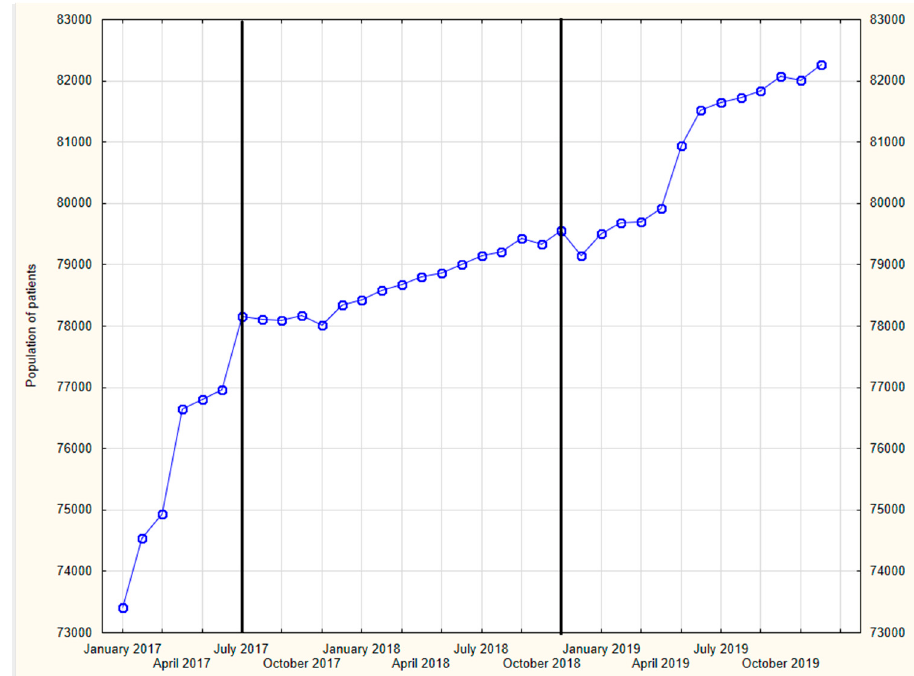
Figure 2. The patient populations from 2017 to 2019.